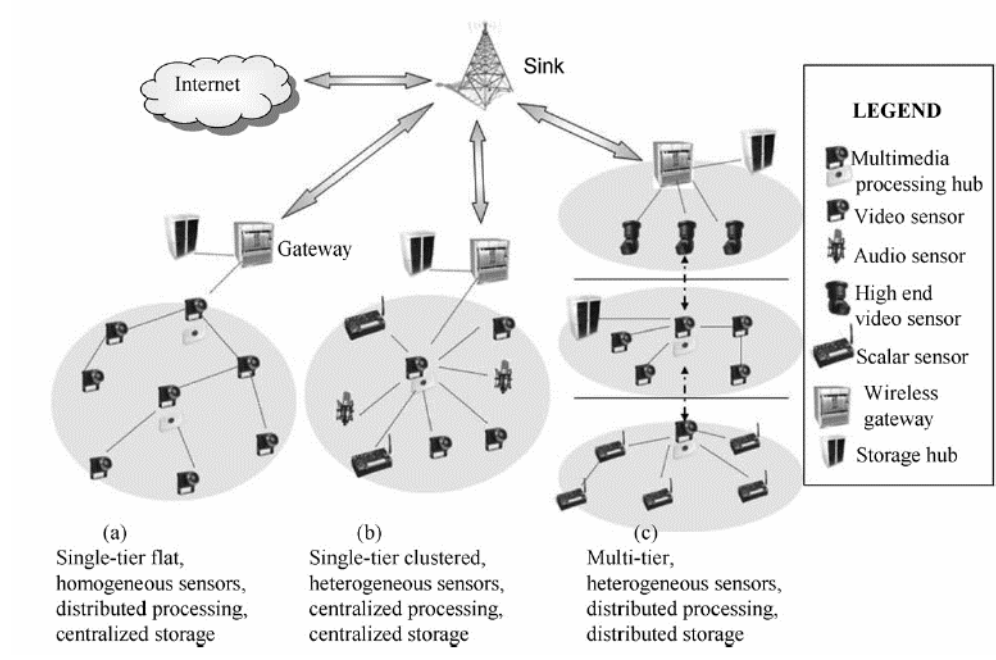
Figure 2. Reference architectures for WSNs